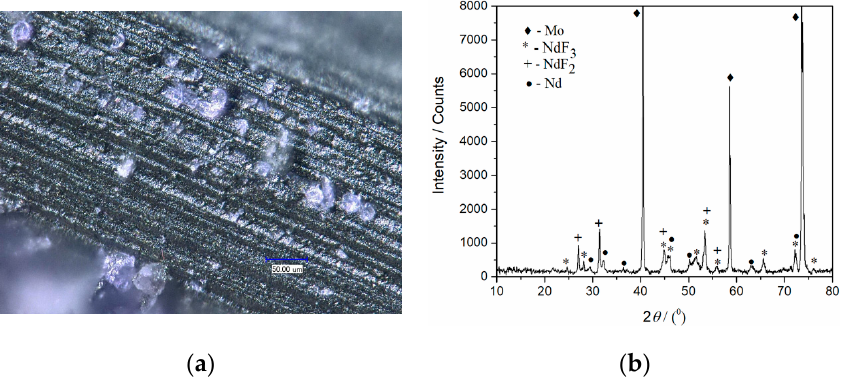
Figure 9. ( a ) Optical image of the Mo working electrode after deposition at − 0.80 V for 7200 s in molten NdF 3 –LiF–Nd 2 O 3 electrolyte system, at 1323 K (the solidified electrolyte was removed from the electrode surface, magnification 600 × ); ( b ) XRD spectra of the Mo working electrode from Figure 9a.